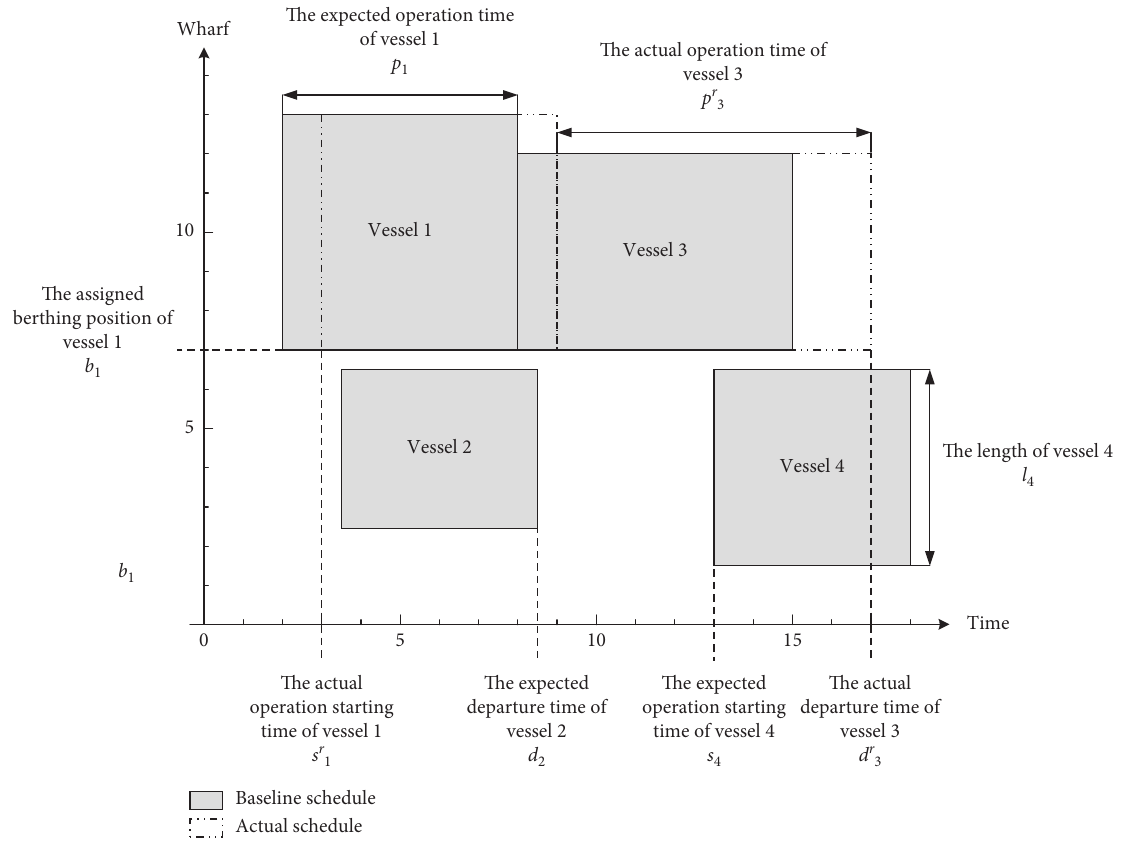
Figure 1: Time-space two dimensional diagram for a berth plan. Table 1: The notations used for berth plans. Table 2: Data settings of the example instance. Vessel